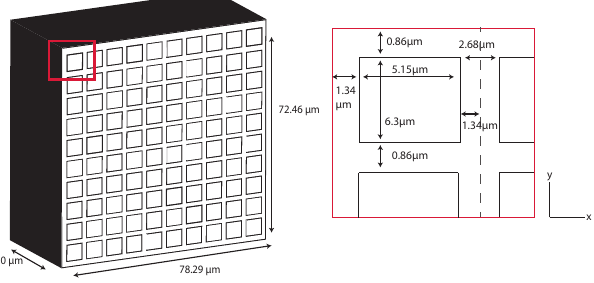
Figure 4. Dimensions used in the 3-D corridor model. Units =